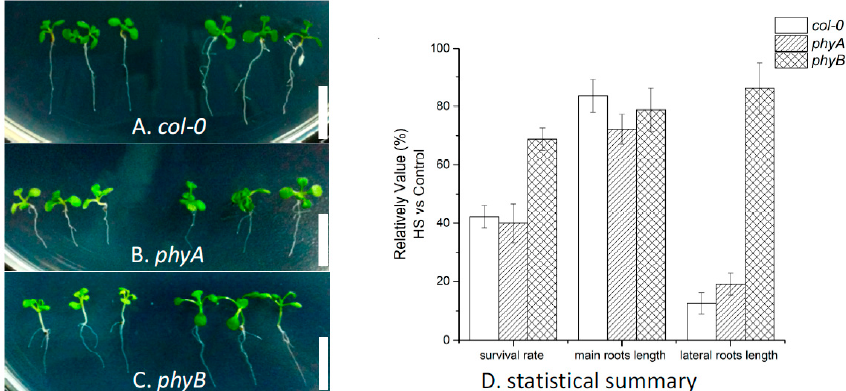
Figure 5. Root development of three genotypes of Arabidopsis (control individuals were placed on the right, treated ones left), and statistical summary for phenotype analysis. After treatment at 37 °C for three days, the main roots lengths of all three genotypes were suppressed to a similar degree. Meanwhile, the lateral root development of col-0 and phyA seedlings are severely inhibited (see ( A , B , D )). However, the lateral roots of phyB showed superior development (see ( C , D )). Scale bars, 1 mm.